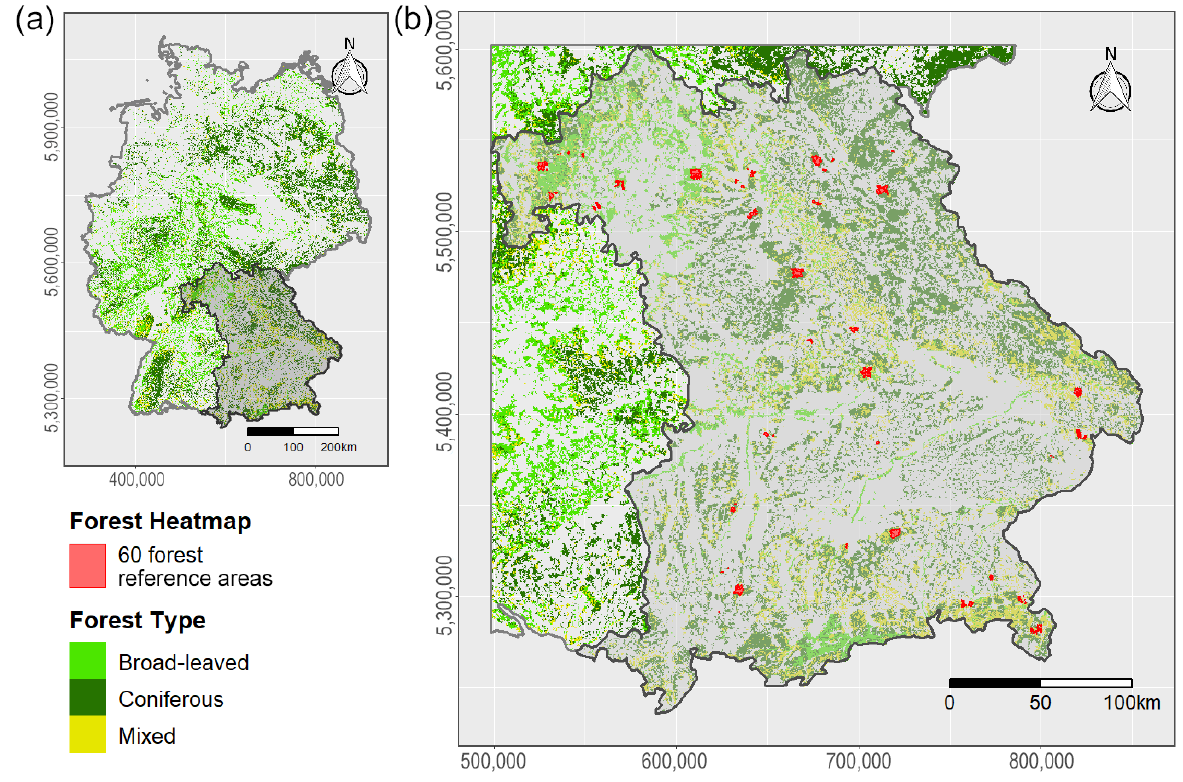
Figure 2. Study area covering all German forest regions for Analysis Level 1 ( a ), as well as 60 forest reference areas across Bavaria with information about dominant tree species and forest age for Analysis Level 2 ( b